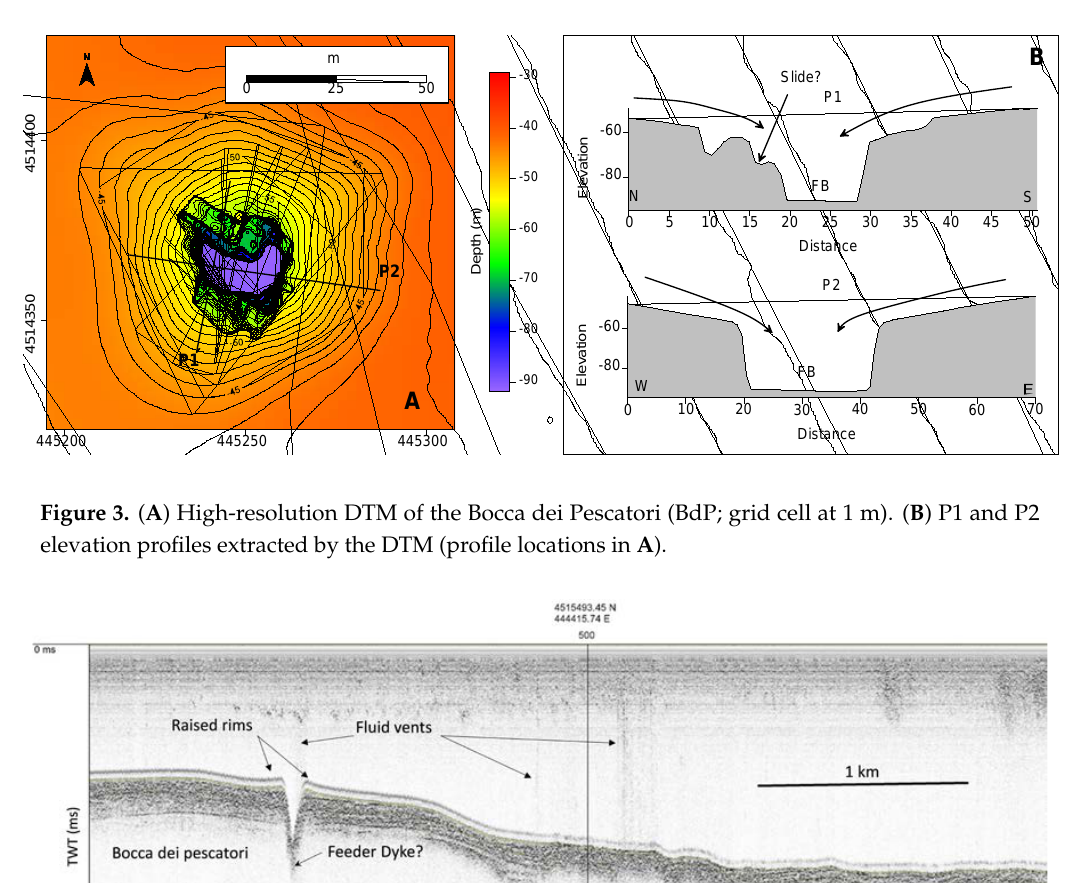
Figure 3. ( A ) High-resolution DTM of the Bocca dei Pescatori (BdP; grid cell at 1 m). ( B ) P1 and P2 elevation profiles extracted by the DTM (profile locations in A ).